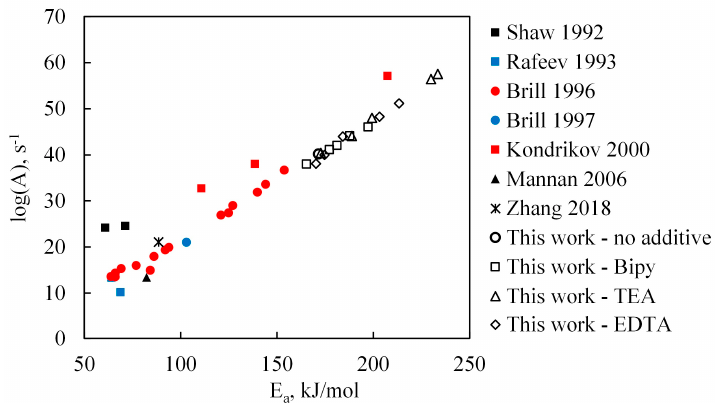
Figure 10. Literature review by Zhang [6] comparing the Arrhenius parameters of various HAN samples with their analytical prediction. No additive (90% aqueous) HAN, Bipy, TEA, and EDTA additive data from this work were compared.